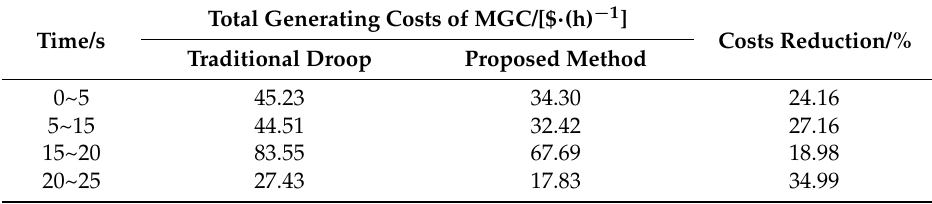
Figure 5. The active power using the traditional droop control in MGC. Table 2. Comparison of total generating costs, using different methods in MGC.